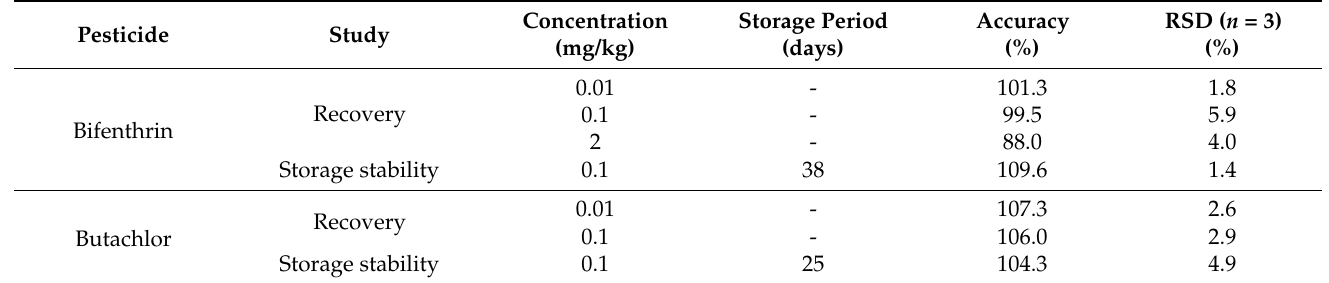
Table 4. The accuracy and precision of bifenthrin and butachlor for recovery and storage stability studies using the established